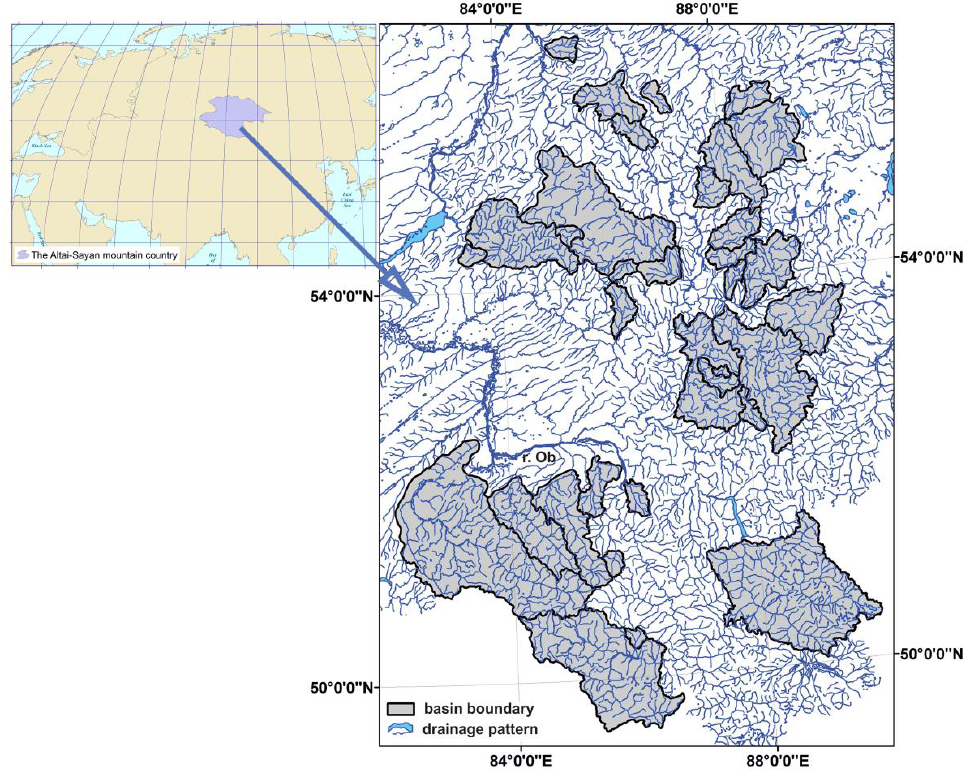
Figure 1. Map scheme of the location of 34 model river basins of the Altai-Sayan mountain coun- try